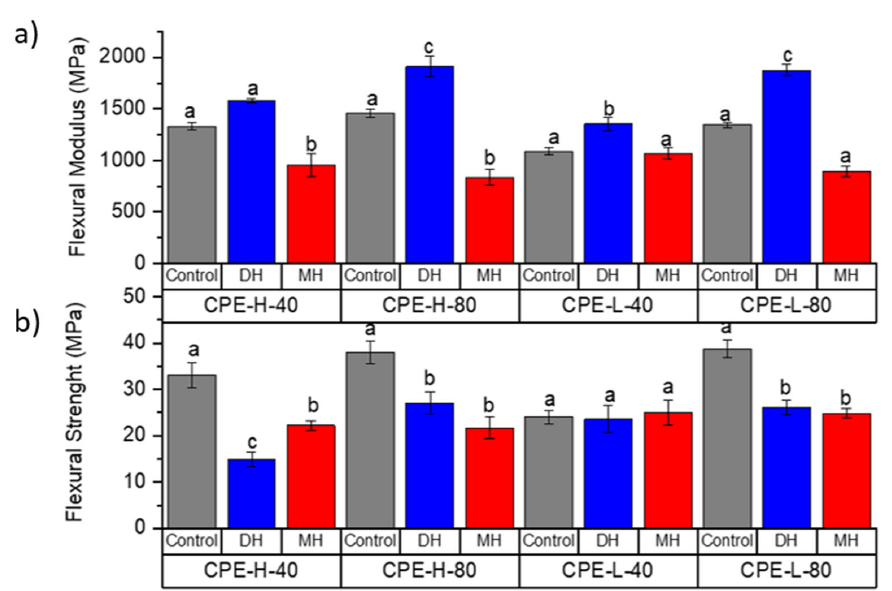
Figure 7. Change in the flexural modulus ( a ) and flexural strength ( b ) of the FDM dumbbells due to the DH or MH sterilization process as measured in the CPE. Grey bar: control sample; blue bar: dry heat sterilization; and red bar: moist heat sterilization. a–c Different letters show statistically significant differences between formulations ( p < 0.05).